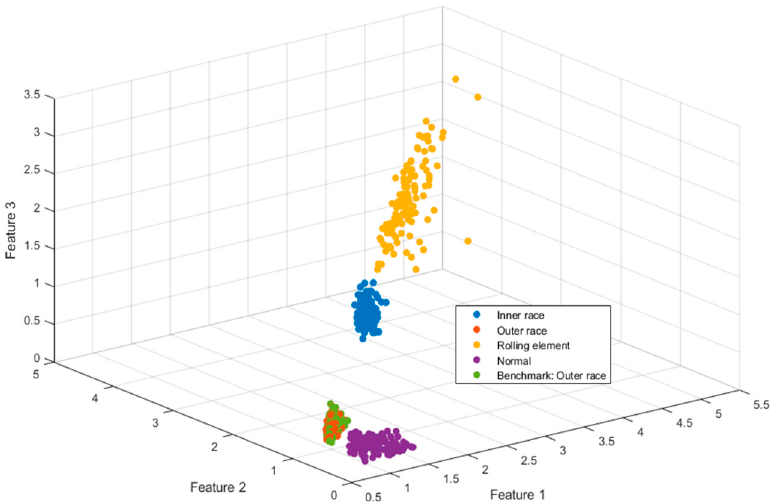
Figure 9. The classification result of outer race.